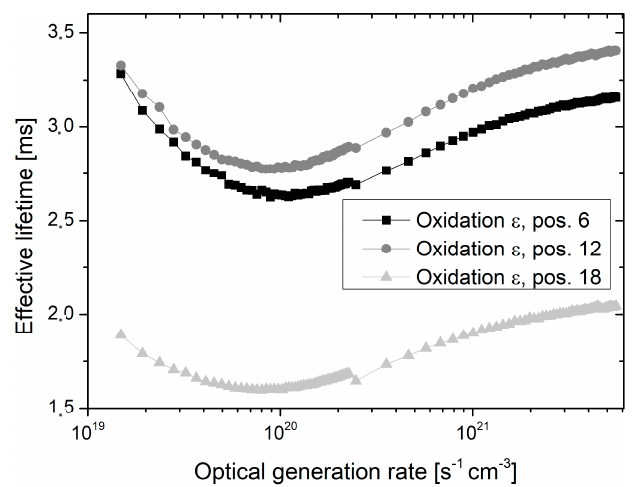
Figure 10. Effective lifetime as a function of the optical generation rate measured in the center of wafers, which were extracted from oxidation run δ and placed in quartz boat positions 6, 15, and 26, respectively. Quartz boat position 26 is located in direction of the tube door.